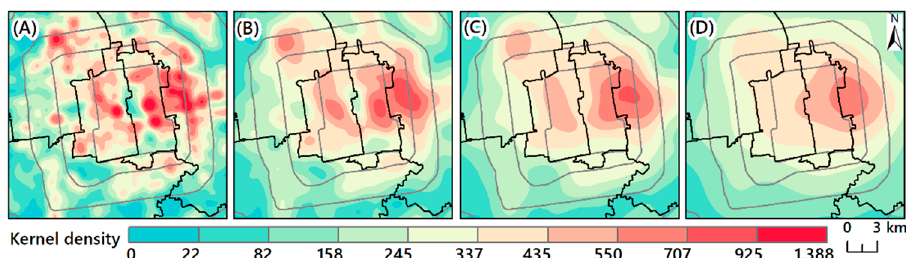
Figure 7. Spatial distribution of POI kernel density with di ff erent search radii. ( A ) 1000 m; ( B ) 2000 m; ( C ) 3000 m; ( D ) 5000